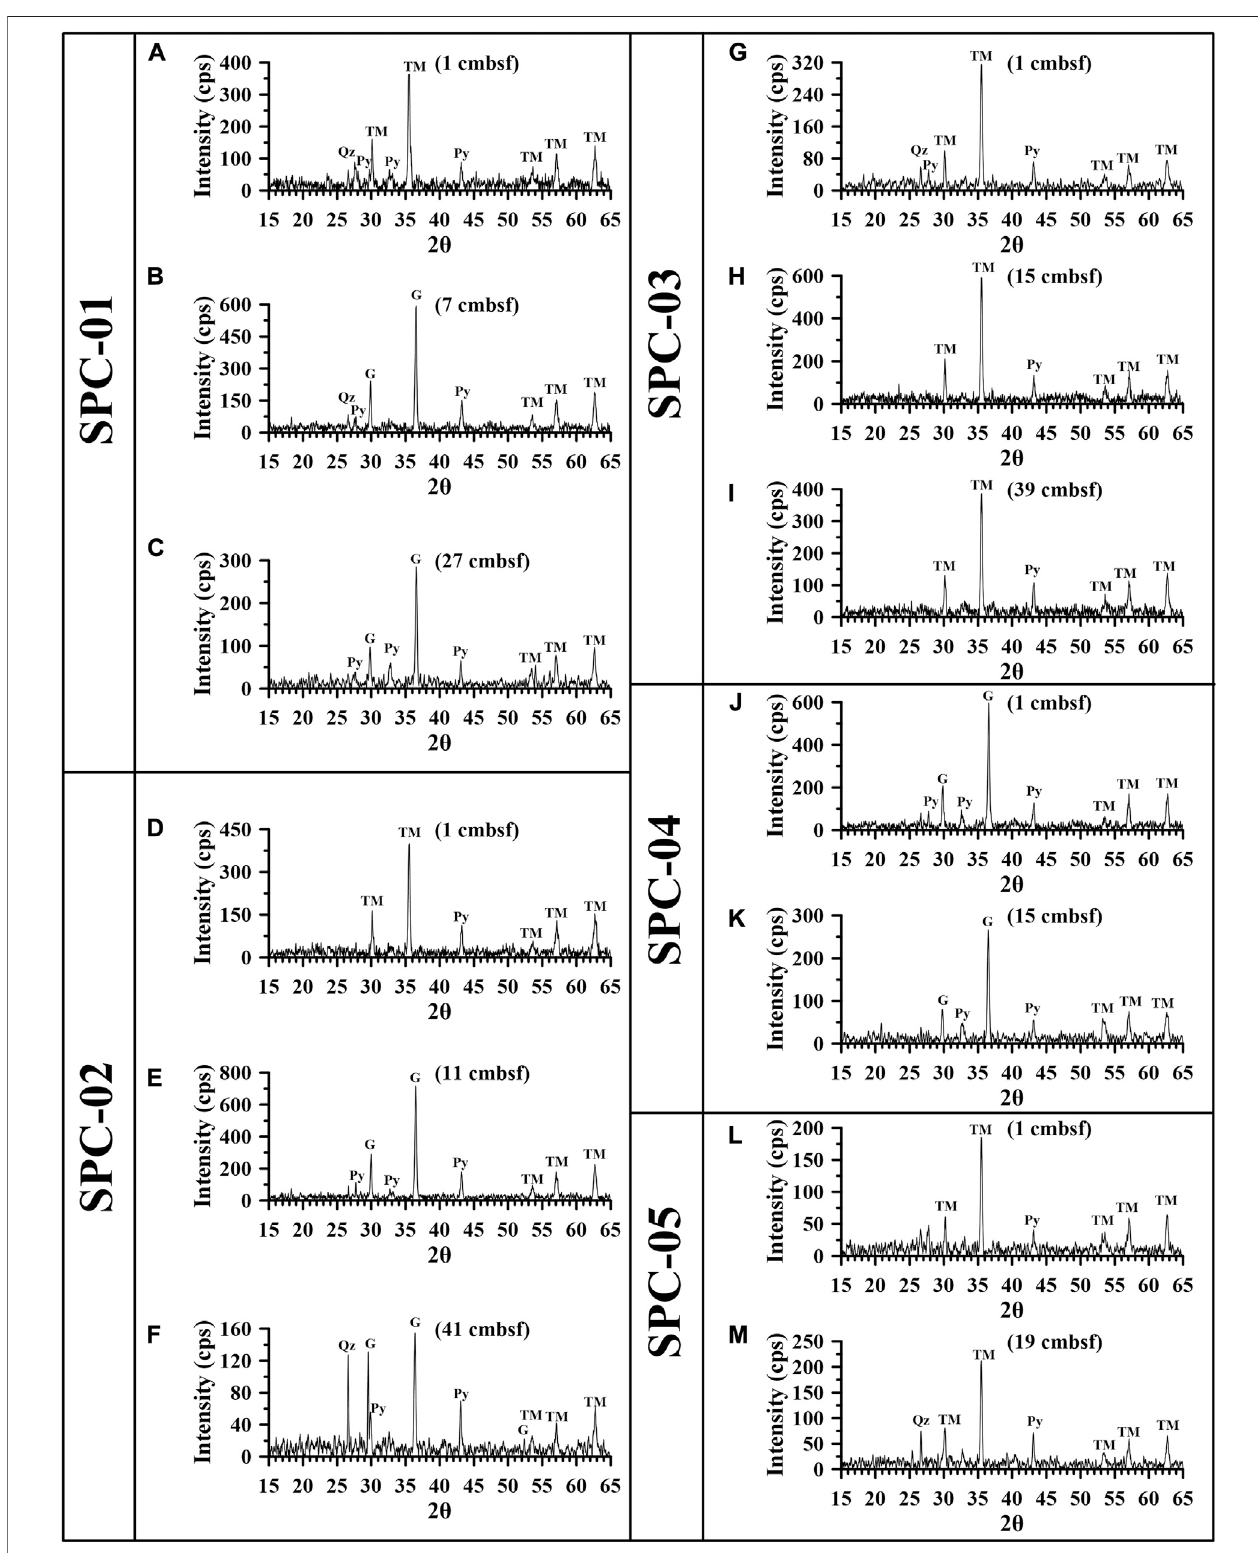
FIGURE 6 | X-ray diffraction spectra for magnetic minerals extracted from different sediment core depth intervals of spade cores. (A – C) : SPC-01, (D – F) : SPC-02, (G – I) : SPC-03, (J – K) : SPC-04, and (L – M) : SPC-05. TM, titanomagnetite; P, pyrite; Qz, quartz, and G, greigite.